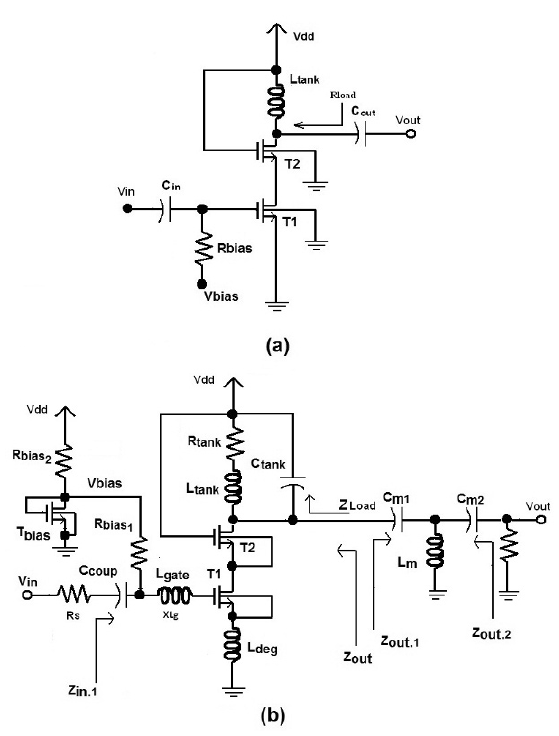
Figure 1. a) The basic common source unmatched (core) stacked amplifier; b) the proposed K-band single-stage matched wideband amplifier with a diode-connected biasing device